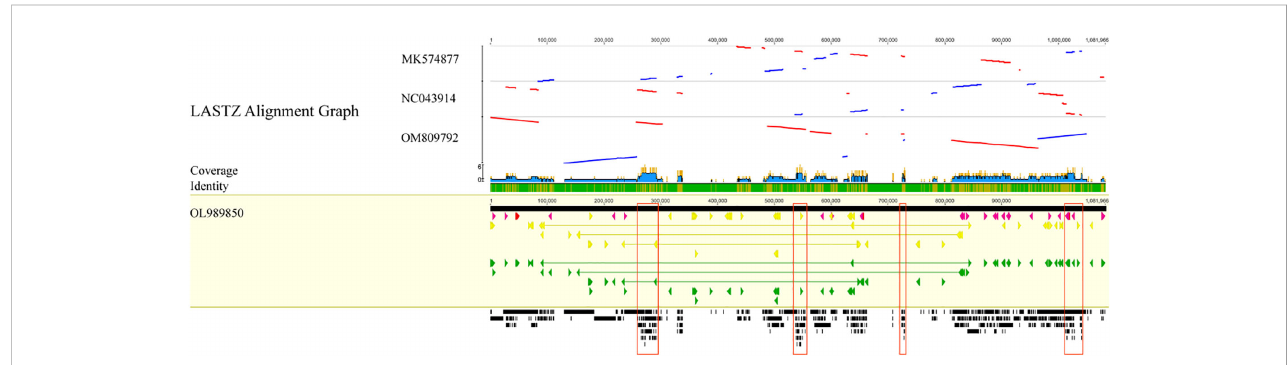
FIGURE 9 Four Theaceae mitochondrial genomes aligned collinearly.High-scoring segment co-direction pairings are shown by blue bars, and reversed pairs are shown by red bars. Arrows in yellow indicate coding sequences, red ribosomal RNA genes, purple transfer RNA genes, green protein-coding genes, and gray exonic areas. In this case, the larger the black squares, the more genetic material the two species share.Conservative regions are red. These sections comprise nad5, atp9, cox 2, rps 3, trnA-TGC, trnI-GAT, rrn18, trnV-GAC, and ccmFN.